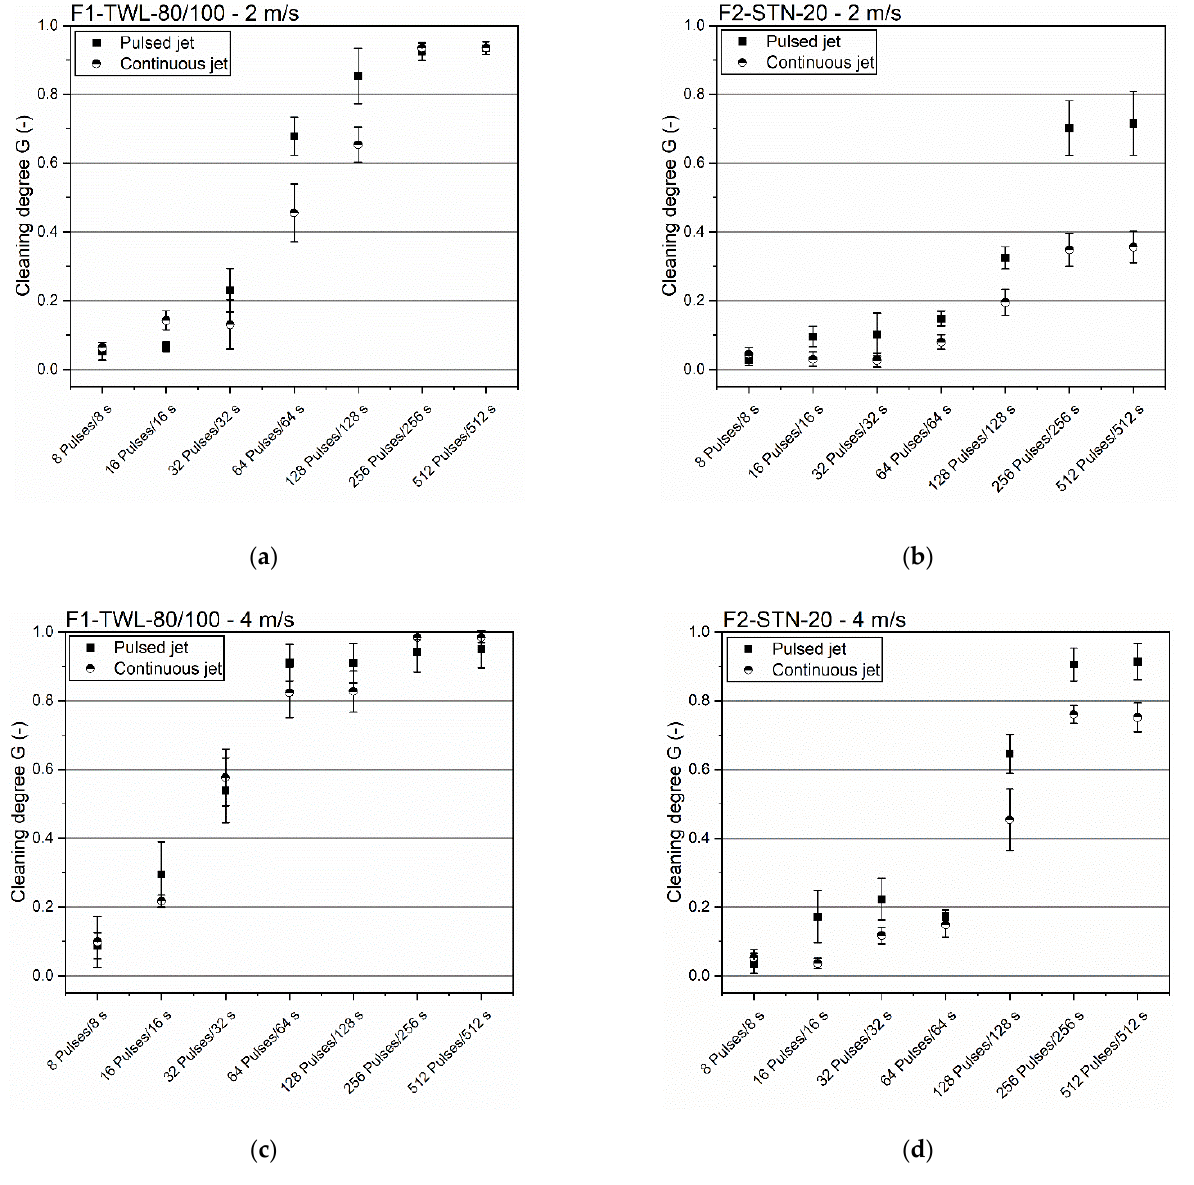
Figure 5. Comparison of pulsed and continuous cleaning with two different cleaning velocities. Settings for pulsed cleaning: t Pulse = t Pause = 0.1 s in a logarithmic interval [8:265]. Continuous cleaning settings: unpaused in a logarithmic interval [8:256] s. ( a ) F1-TWL-80/100 and 2 m/s. ( b ) F2-STN-20 and 2 m/s. ( c ) F1-TWL-80/100 and 4 m/s. ( d ) F2-STN-20 and 4 m/s. n ≥ 5. Confidence intervals with α = 0.05.